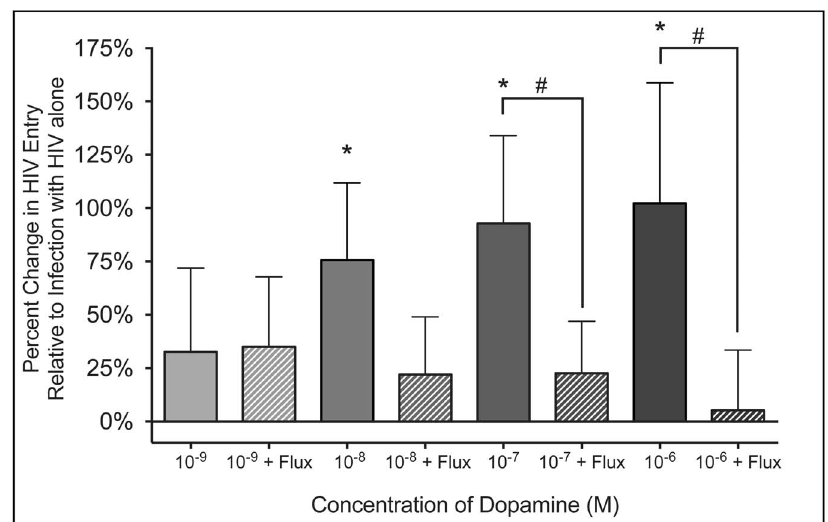
Figure 4. Activation of dopamine receptors required for the dopamine-mediated increase in HIV entry. Macrophages were pretreated with the pan-dopamine receptor (DR) antagonist flupenthixol (flux, 10 6 M) and then MOI 0.01 b -lac HIV was added concurrently with either 10 9 , 10 8 ,